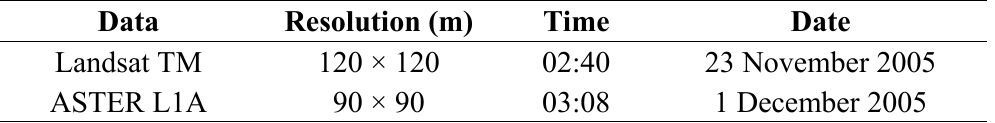
Table 1. Landsat TM and ASTER satellite image data.